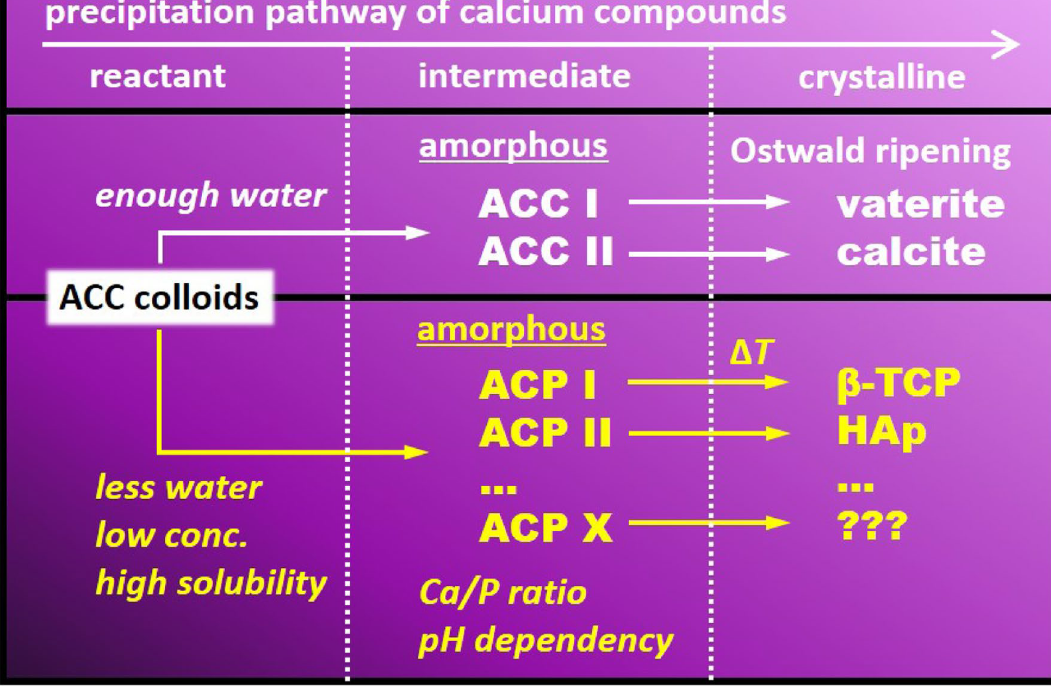
Figure 6. Schematic illustration of calcium phosphate